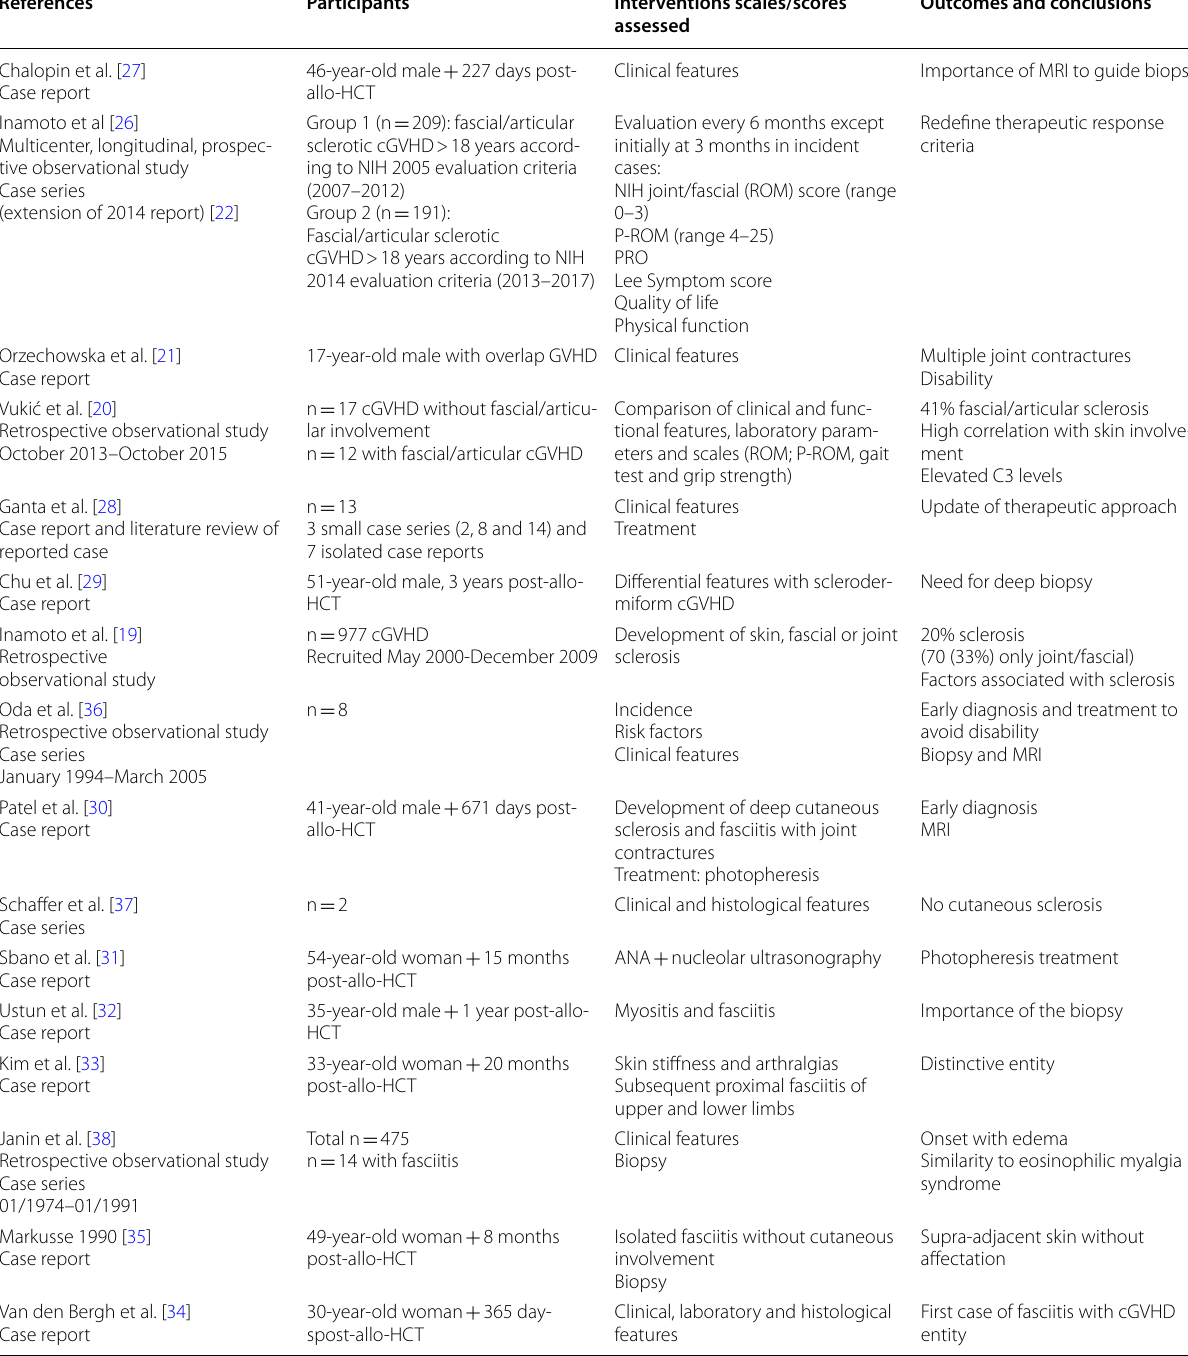
Table 5 Reported cases of EF‑like chronic